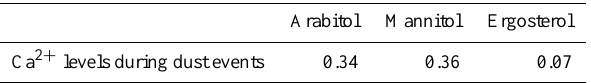
Table 3. Pearson correlation coefficient ( r) between Ca 2 + levels and the measured biomarkers as was calculated for 8 dust events sampled during 2009. Low correlation is observed suggesting that the biomarkers are from a local source.